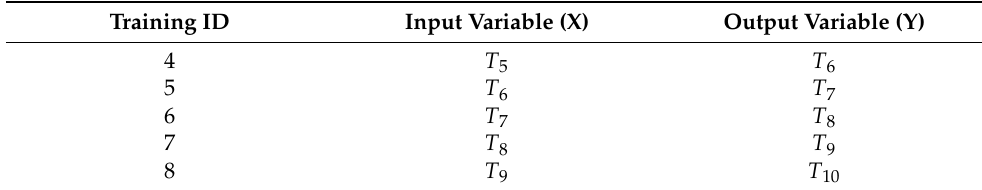
Table 3. An example of a training database with